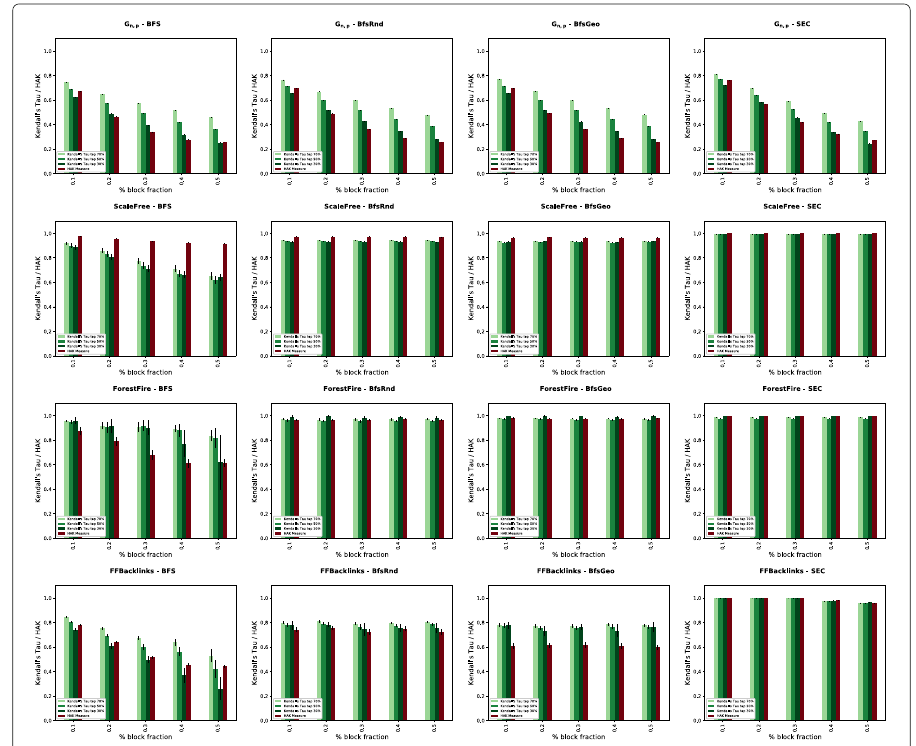
Fig. 4 Ranking deviations measured and estimated with different synthetic graphs and crawls for different fractions of uncrawled vertices (rows) as well as different crawling strategies (columns). Averaged Ranking deviations in 100 crawls (generated using random seed sets) are presented along with 95% confidence intervals Reinforcing our claim, the addition of backlinks in FFBacklinks resulted in a